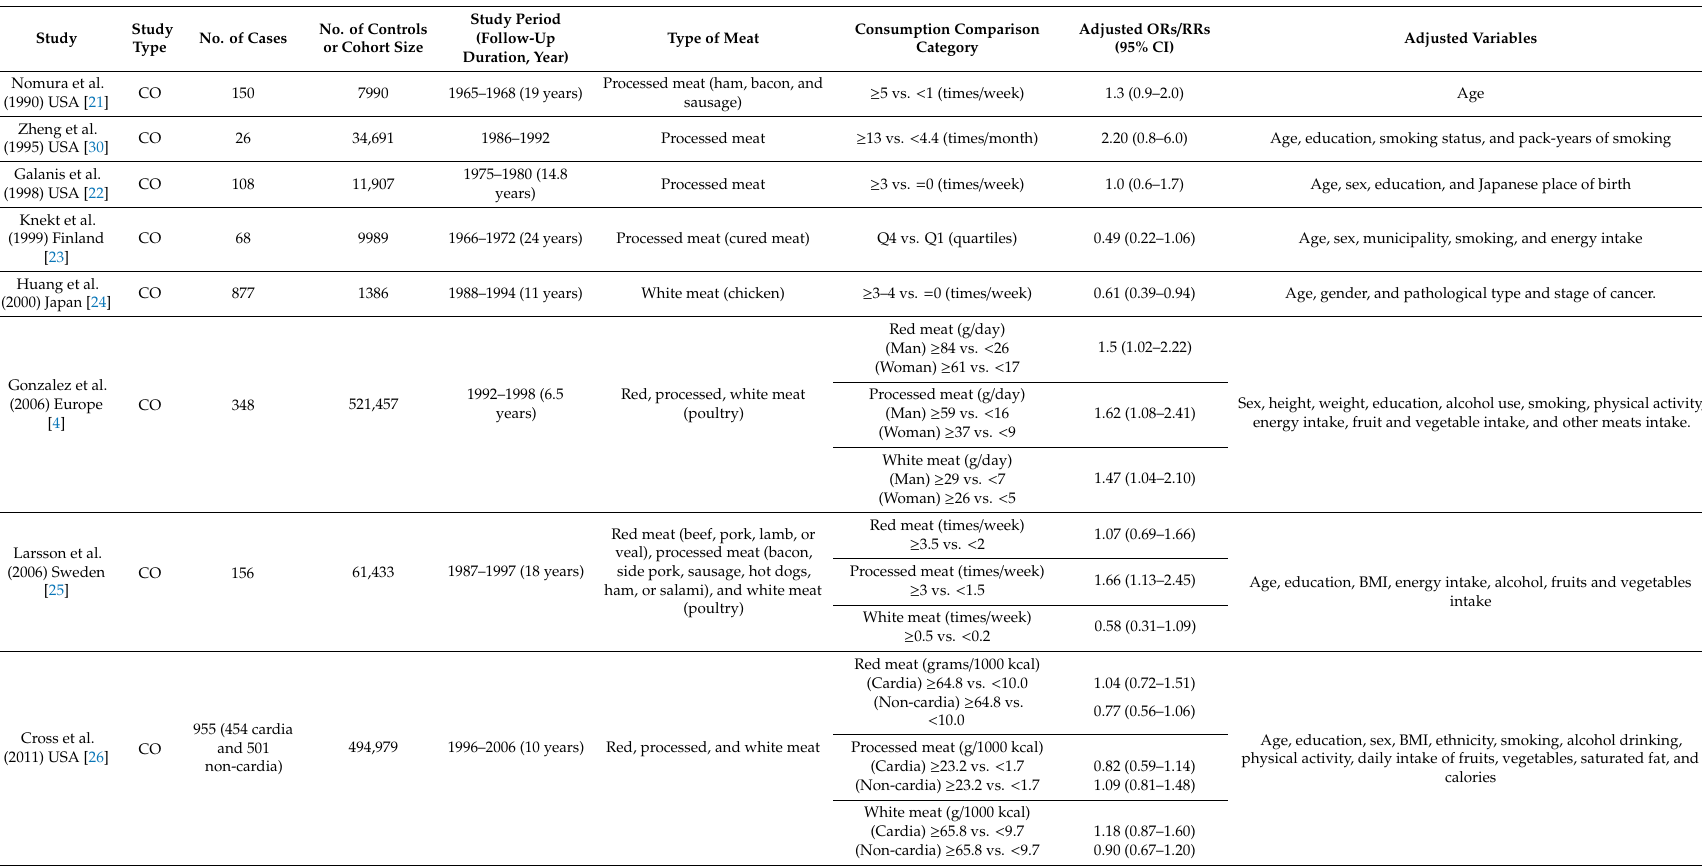
Table 1. Characteristics of included studies associated with red, processed, and white meat consumption and gastric cancer